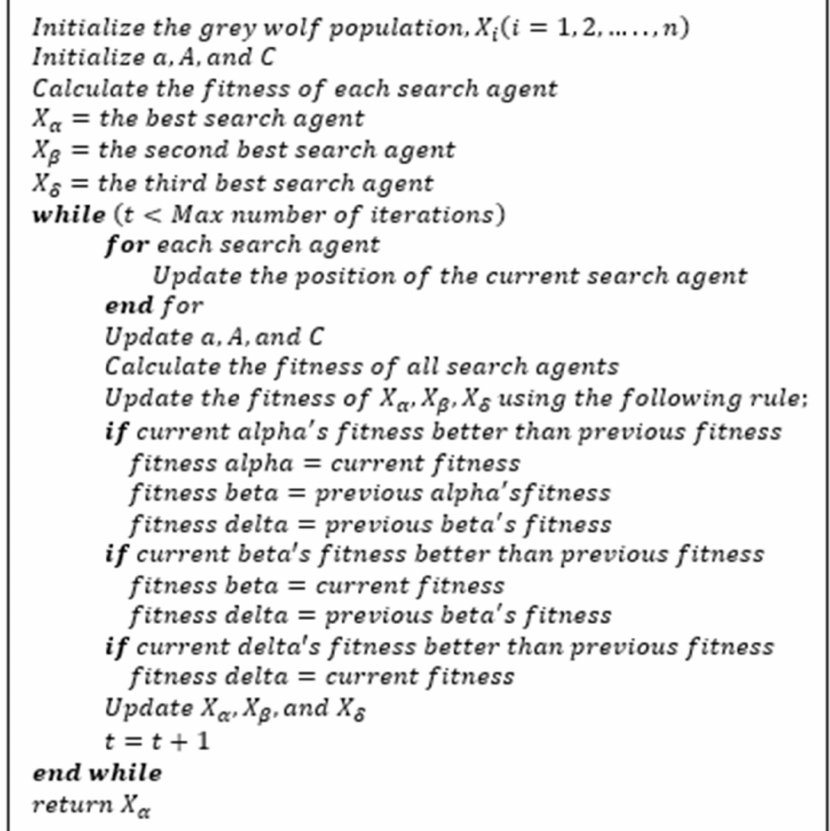
Figure 3. Pseudo-code of improved Grey Wolf Optimization (IGWO)